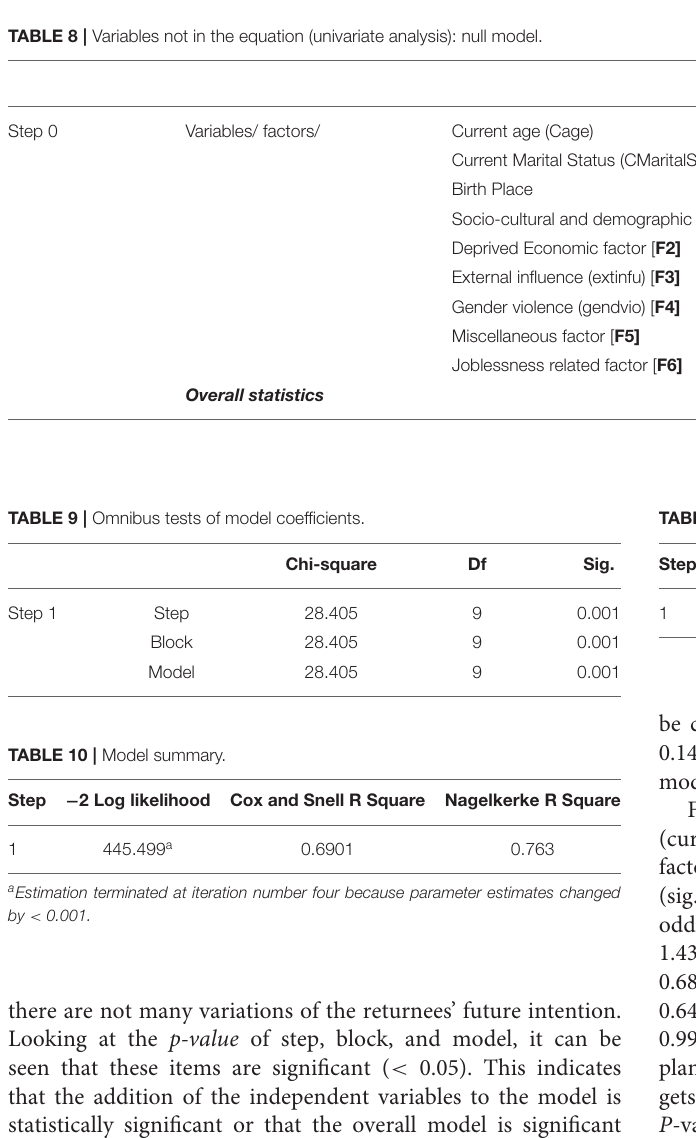
TABLE 8 | Variables not in the equation (univariate analysis): null model.